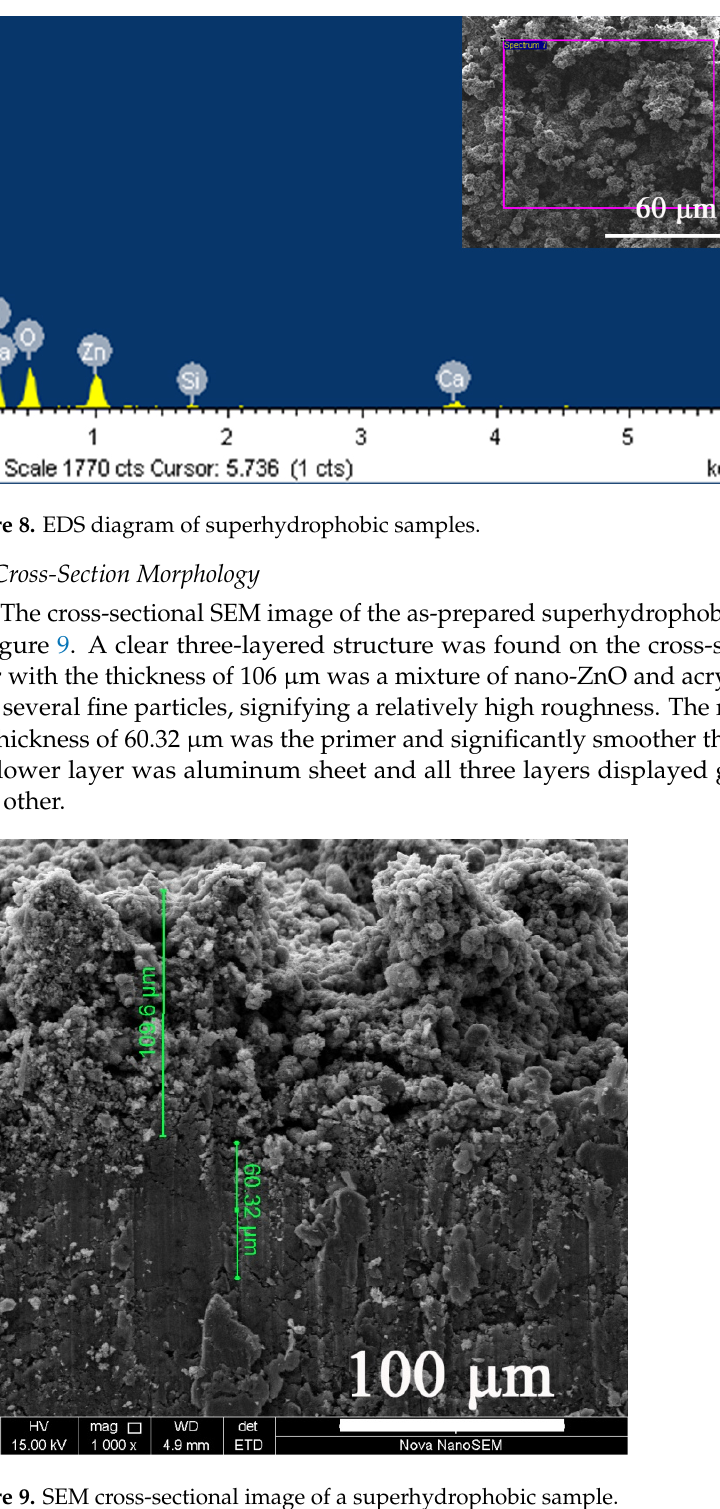
Figure 10. Wettability of samples modified with different mass fractions of HDTMS.